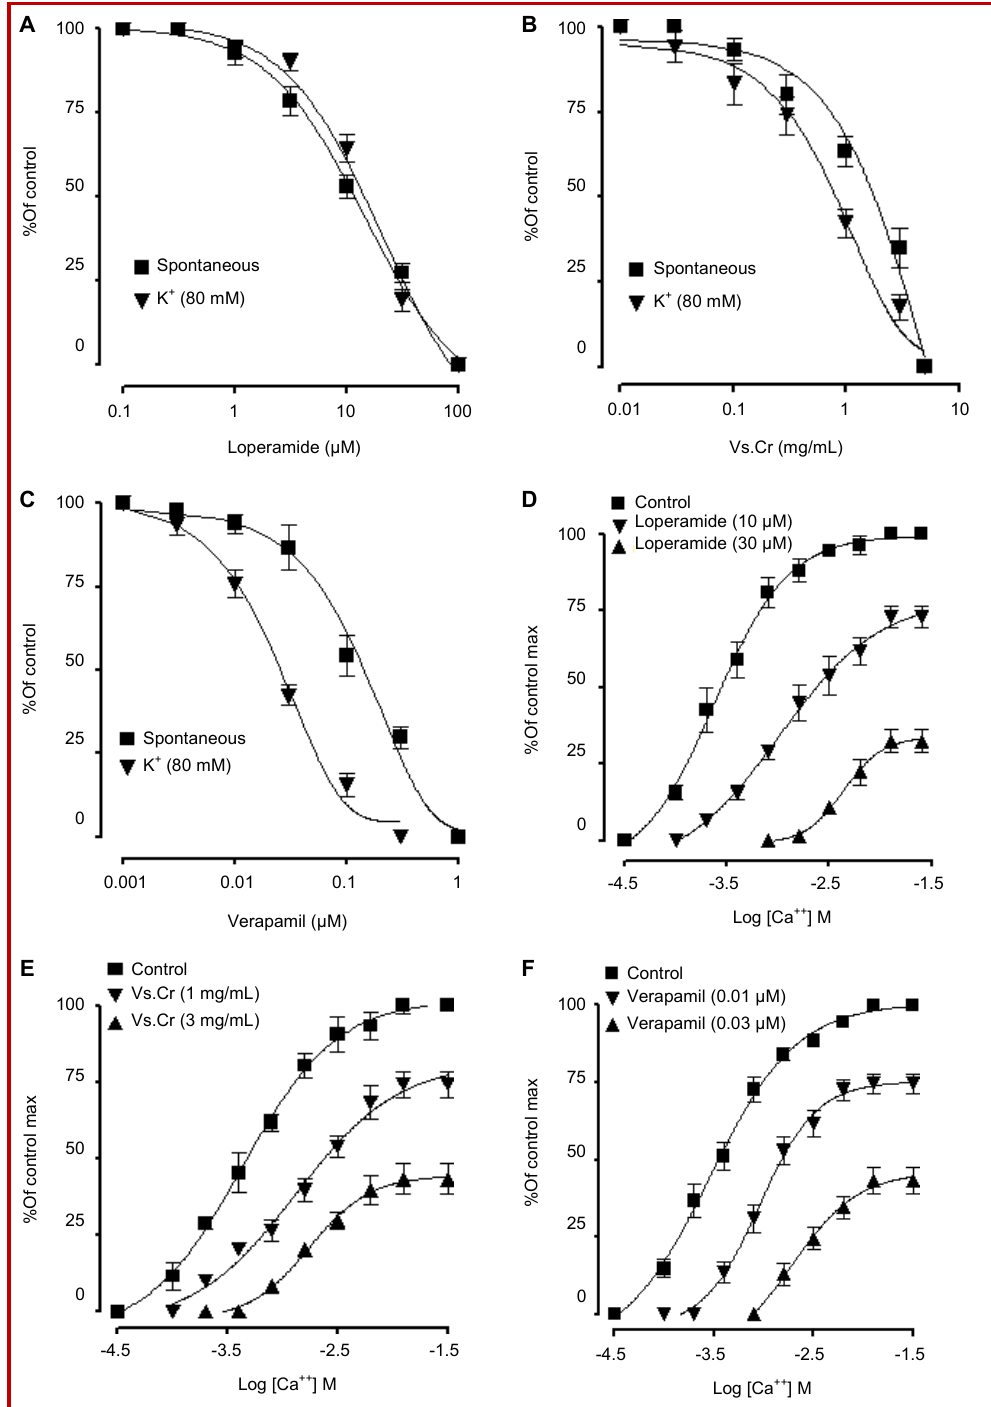
Figure 1: Concentration-response curves of (A) the crude extract of Vincetoxicum stocksii (Vs.Cr), (B) verapamil and (C) loperamide on spontaneous and K + (80 mM)-induced contractions in isolated rabbit jejunum preparations . Figures D, E and F, show respectively, the effect of Vs.Cr verapamil and loperamide on the Ca ++ concentration-response curves in isolated rabbit j ejunum preparations. Values shown are mean + SEM; n=